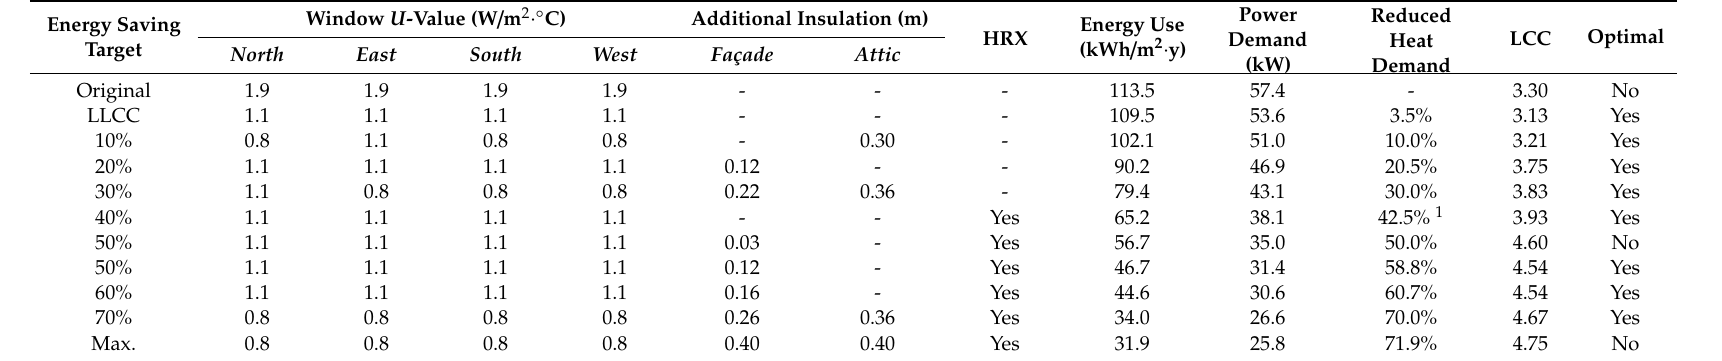
Table 16. EEMs at di ff erent energy saving targets between 10% and 70% for the 1960s building.